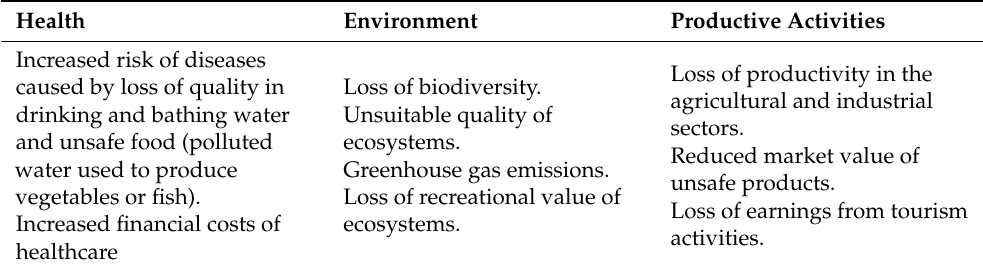
Table 1. Impact of the non-action costs on health, environment, and productive activities. Adapted from Hern á ndez-Sancho et al. [6].